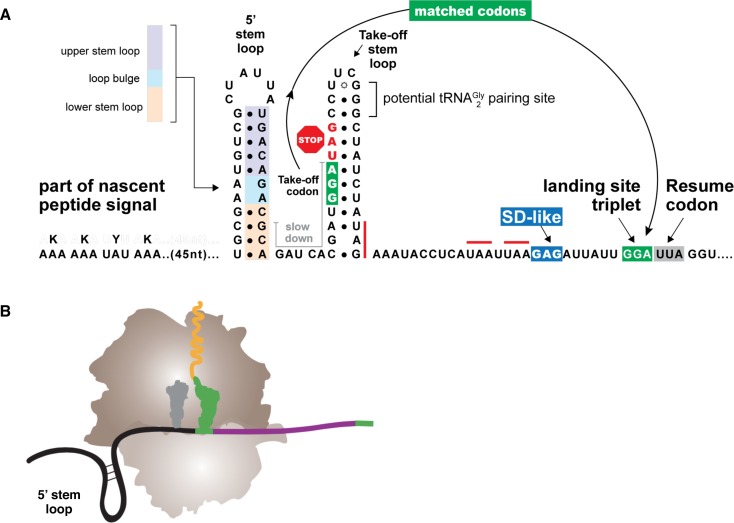
(A) Features important for translational bypassing in decoding T4 gene 60. The matched take-off and landing codons, GGA, are shown in white letters in dark green boxes; the UAG stop codon immediately 3′ of the take-off site is in red letters next to the stop sign; stop codons within the coding gap are overlined in red; and sequences that slow ribosomes on approach to the second stem loop from the left, the take-off stem loop, are overlined in black. A Shine–Dalgarno-like sequence is shown in the blue box, and has a modest influence on landing site selection. The translational resume codon is indicated by the gray box. (B) Model depicting the predicted positioning of the 5′ stem loop and nascent peptide interaction when the GGA take-off codon is in the ribosomal P site. Part B Reproduced in part from Chen, J., Coakley, A., O'Connor, M., Petrov, A., O'Leary, S.E., Atkins, J.F. and Puglisi, J.D. (2015) Coupling of mRNA Structure Rearrangement to Ribosome Movement during Bypassing of Non-coding Regions. Cell, 163, 1267–1280 with permission from Elsevier.